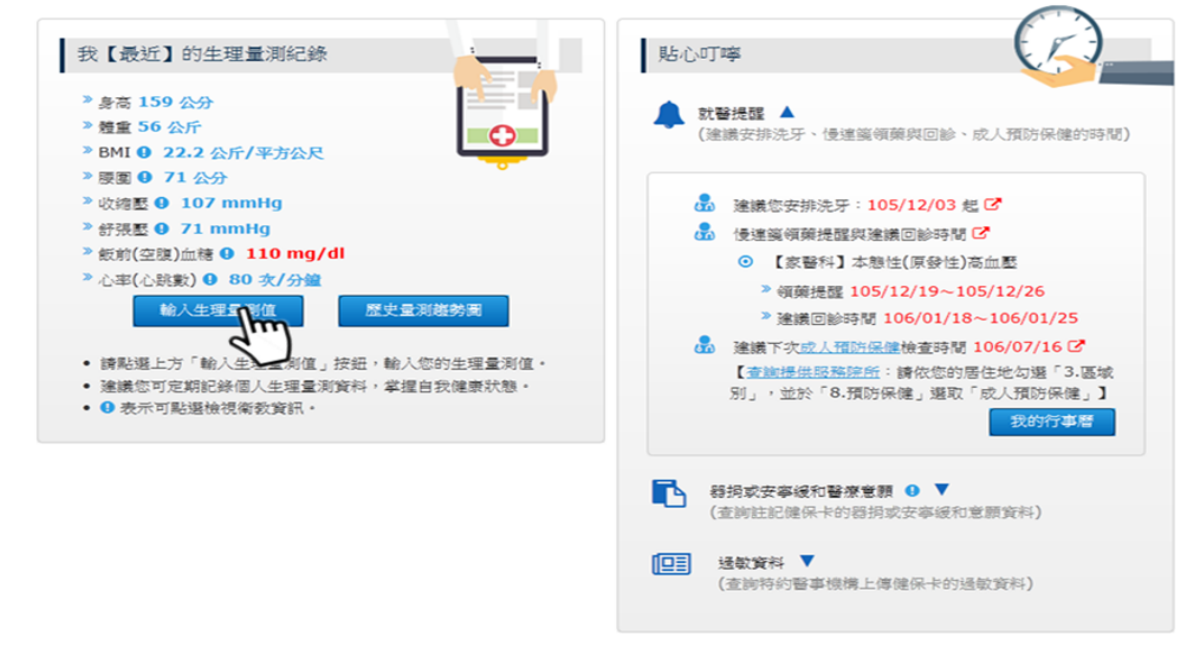
Figure 3. Self-health management (screenshot from My Health Bank): Physiological measurement data, such as height, weight, and blood pressure, are entered and historical trends are monitored. In addition, the system proactively reminds the user about dental cleaning, continuous prescription collection, and health